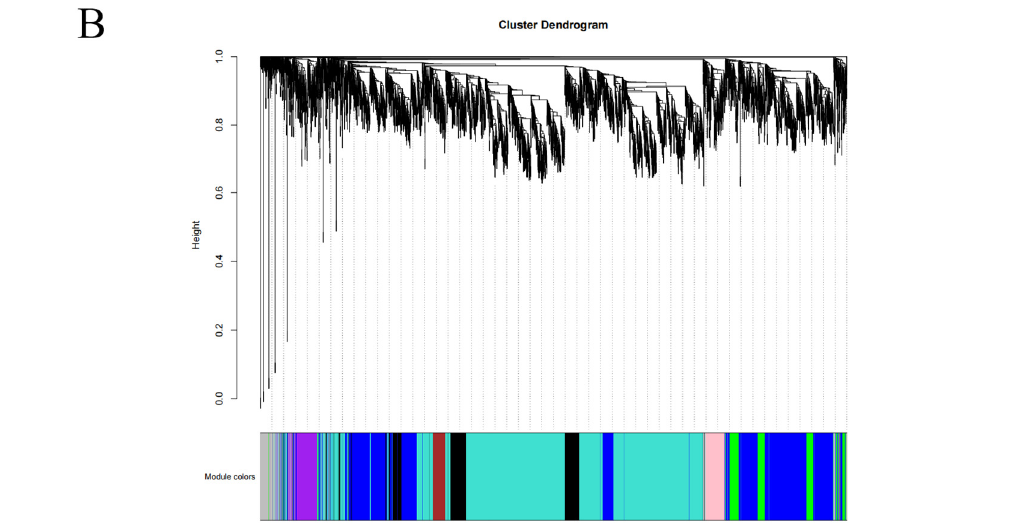
Figure 6. ( A ) Analysis of network topology for different soft threshold powers. The figure on the left shows the influence of the soft threshold power on the scale-free topology fitting index, the figure on the right shows the effect of soft threshold power on average connectivity; ( B ) gene clustering tree (dendrogram) obtained by hierarchical clustering of adjacency-based dissimilarity.